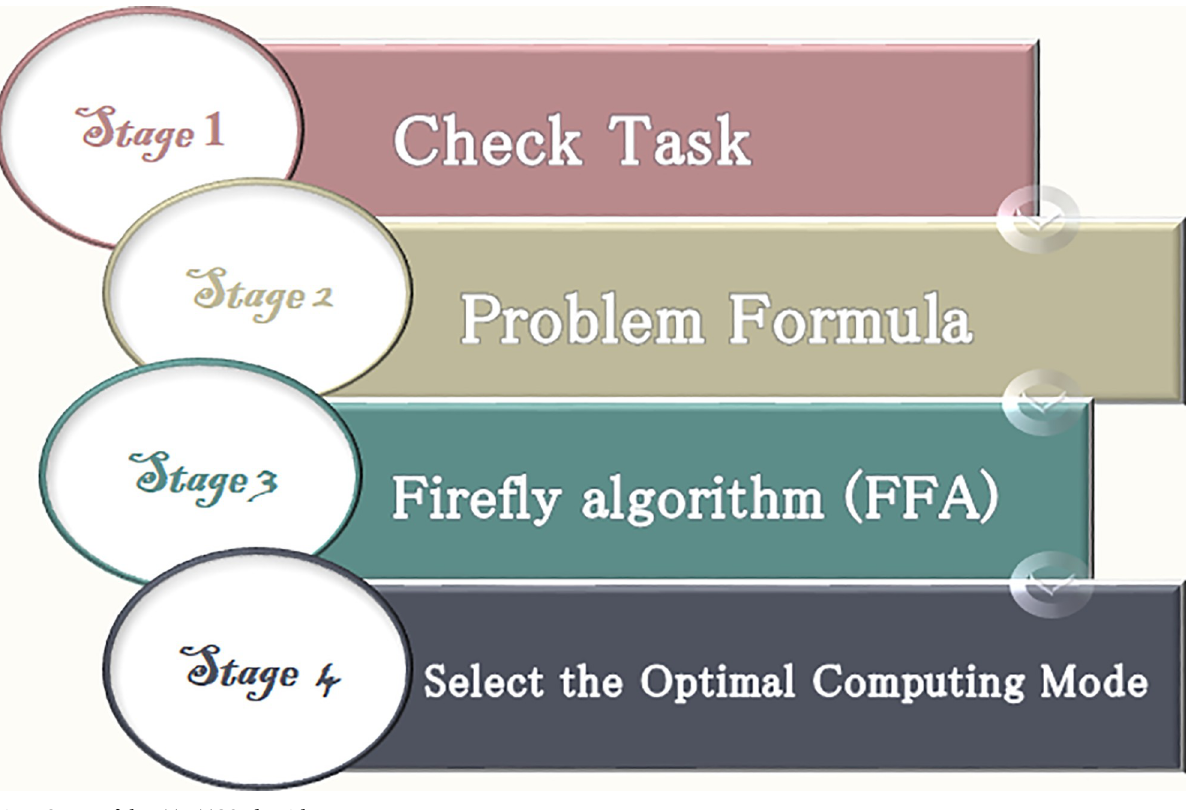
Fig 3. Stages of the ET-DTCO